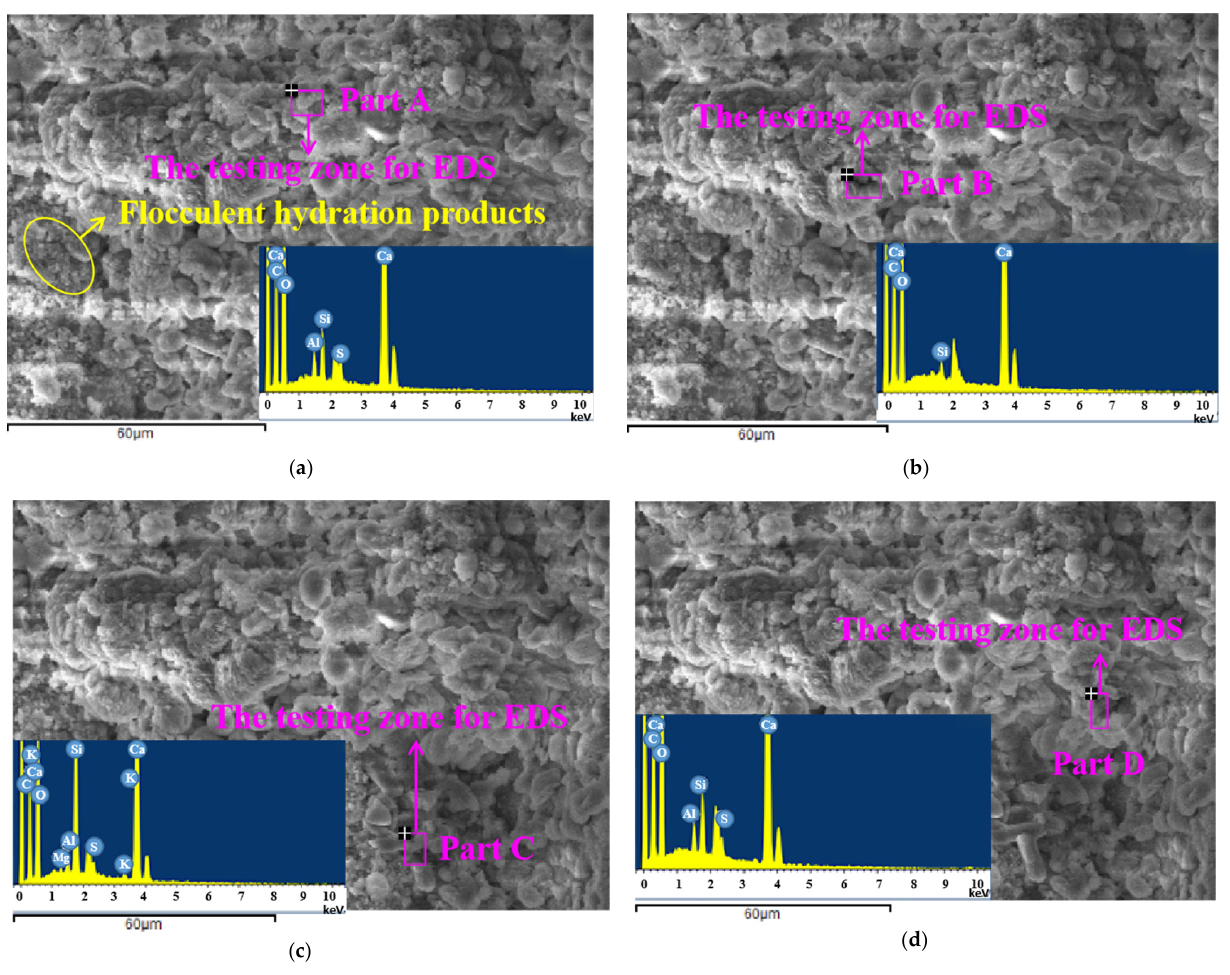
Figure 13. SEM-EDS of sample of four parts. ( a ) SEM-EDS of Part A. ( b ) SEM-EDS of Part B. ( c )